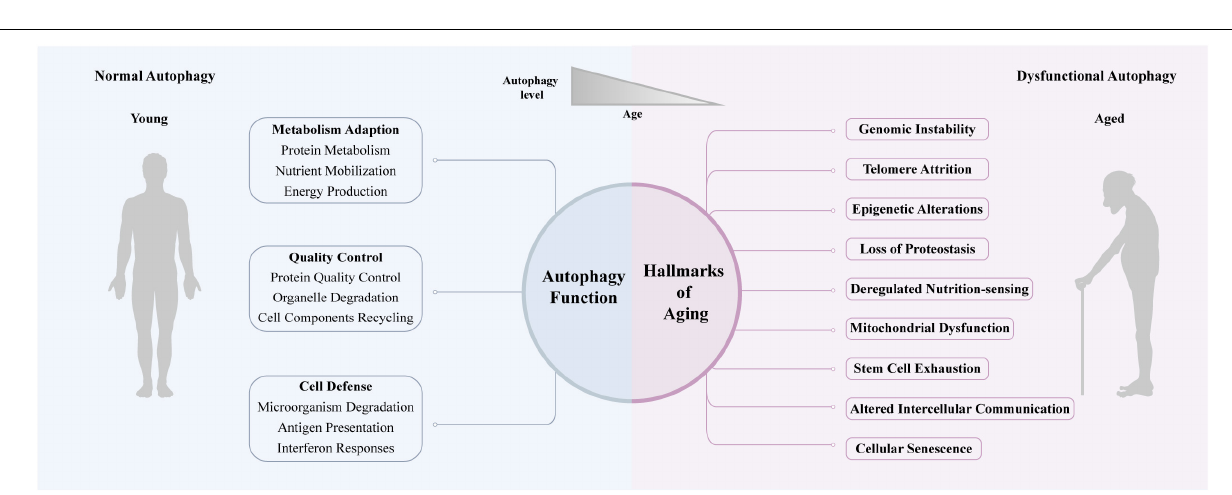
FIGURE 1 | Molecular mechanism of autophagy. Autophagy involves a series of steps including initiation, nucleation, elongation, maturation, fusion, and degradation. AMPK (positive regulator) and mTOR (negative regulator) are the main regulators of autophagy. Functional complexes comprising Atg proteins coordinates and direct the formation of the autophagosome.